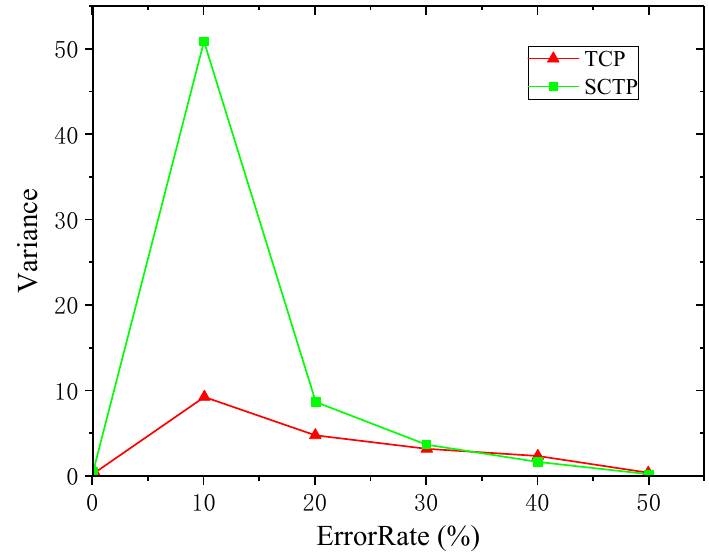
Figure 5. Compare the throughput variance between SCTP and TCP.